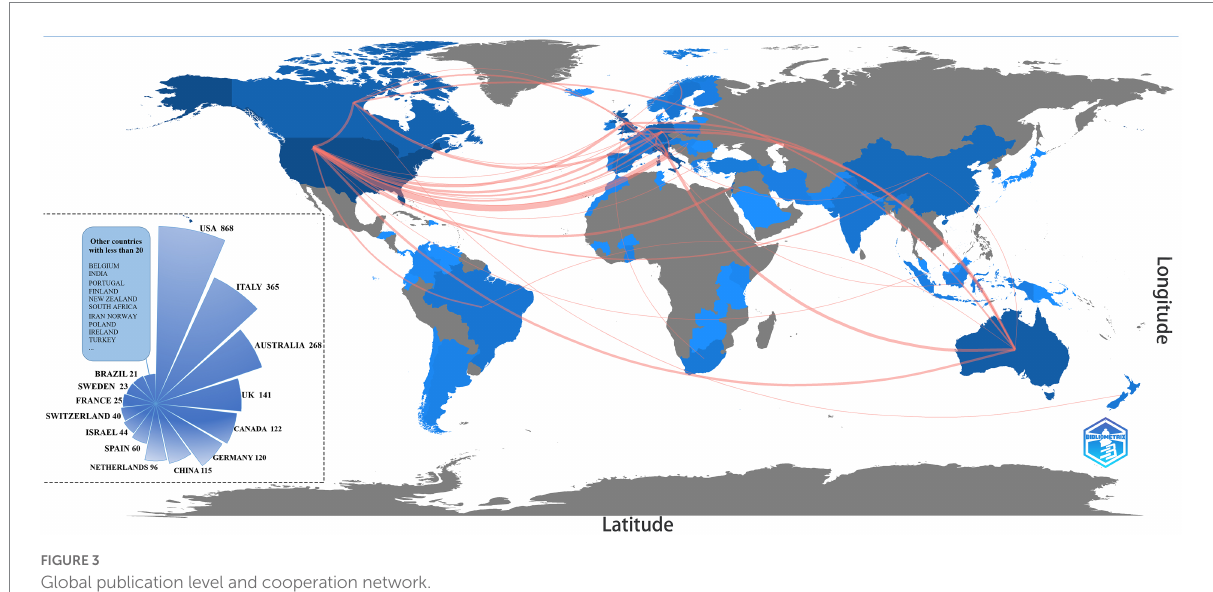
FIGURE 3 Global publication level and cooperation